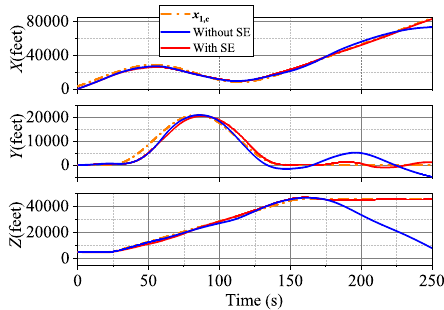
Figure 16. Results for X , Y , and Z .